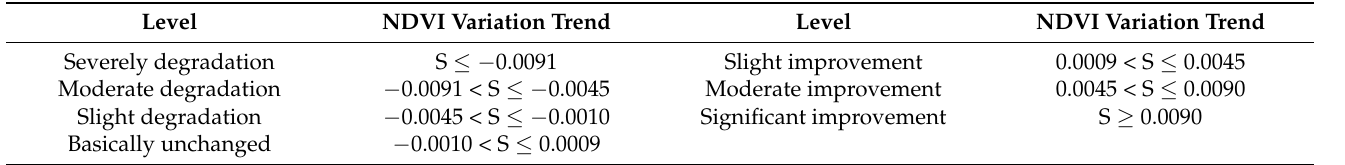
Table 1. Classification standard for vegetation coverage